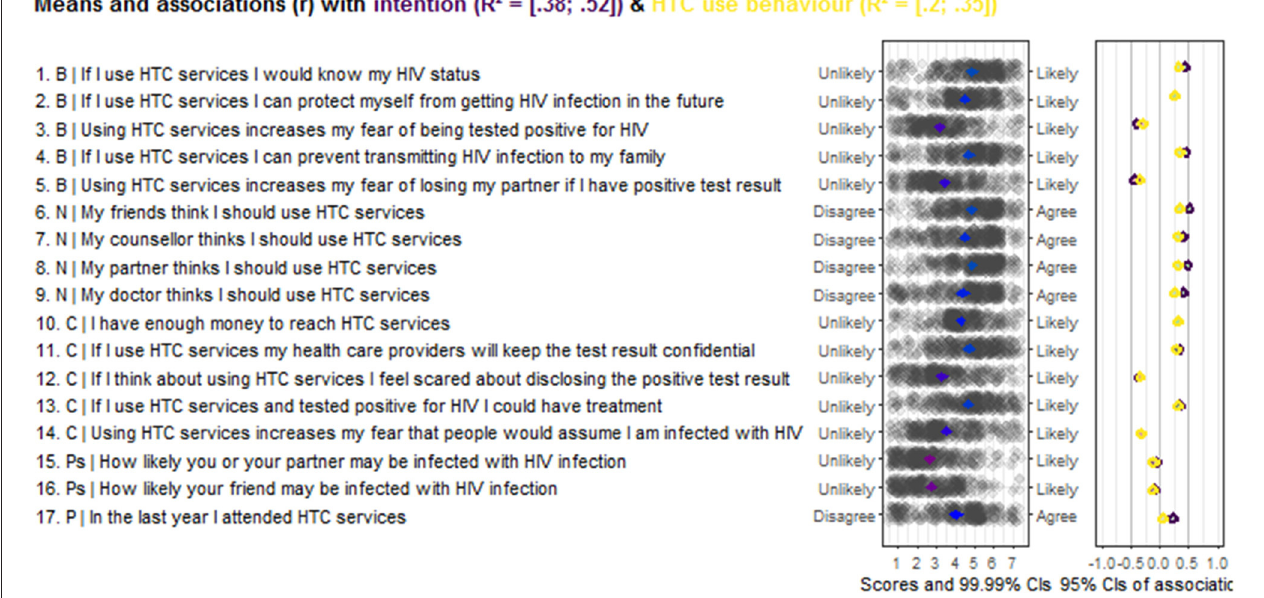
Based on all the social cognitive beliefs included in the study, the explained variance in the intention and HTC use behaviour ranged from 38 to 52% and 20 to 35%, respectively. This result fits with Armitage and Conner’s meta-analysis (31), in which they reported an explained variance of 27% in the behaviour and 39% in the